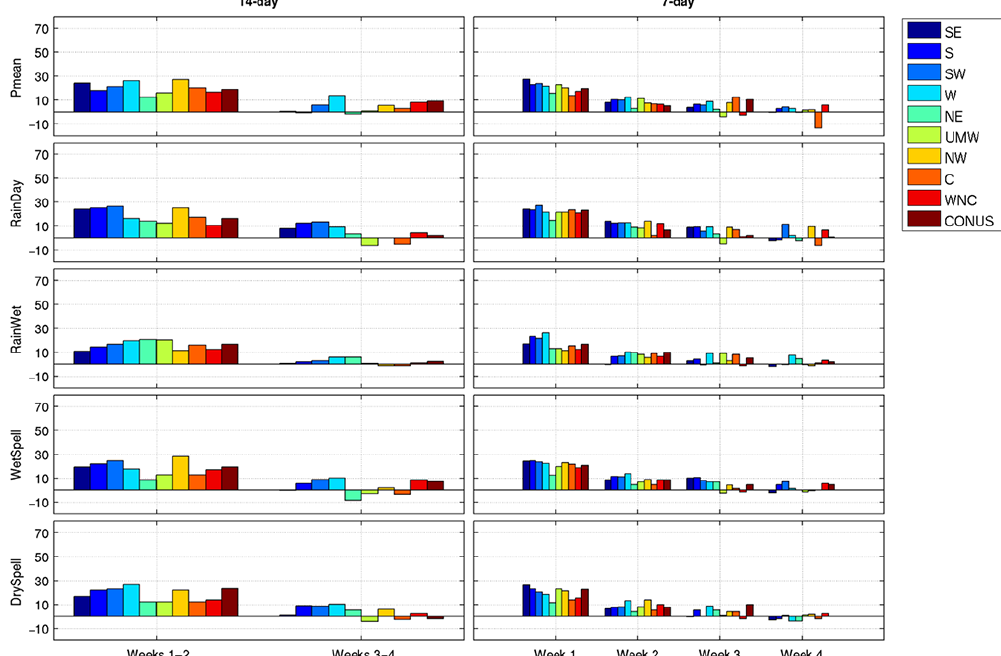
Figure 9. Mean HSS of 14- and 7-day (from top to bottom rows) P mean , WetRain, RainDay, WetSpell, and DrySpell from the CFSv2 daily hindcasts for the CONUS and its consistent NCEI climate